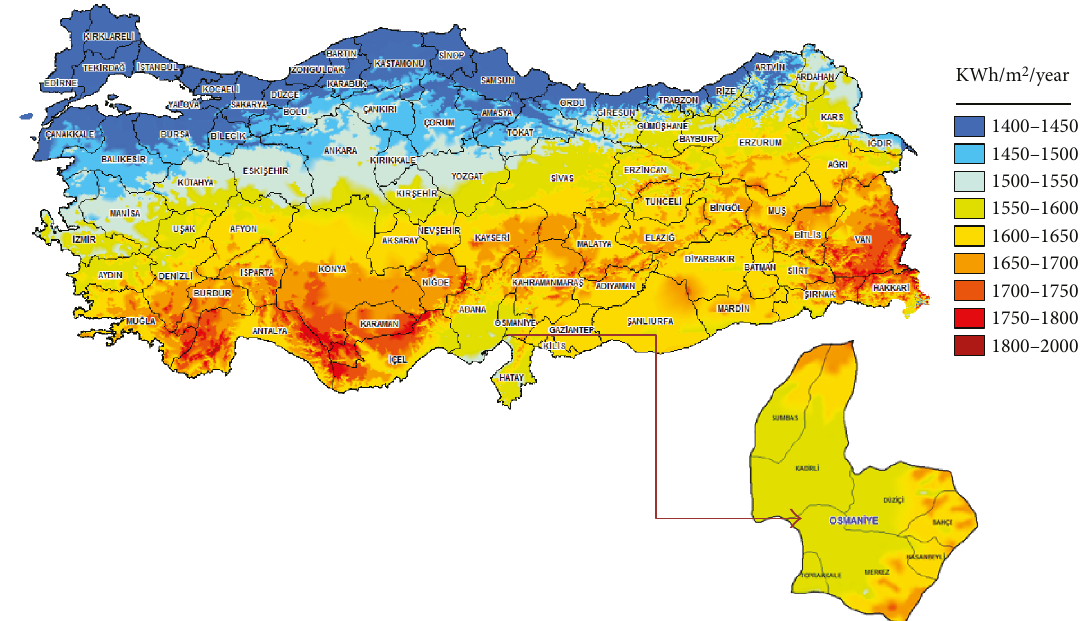
Figure 1: Annual solar energy capacity and location of Osmaniye in Turkey